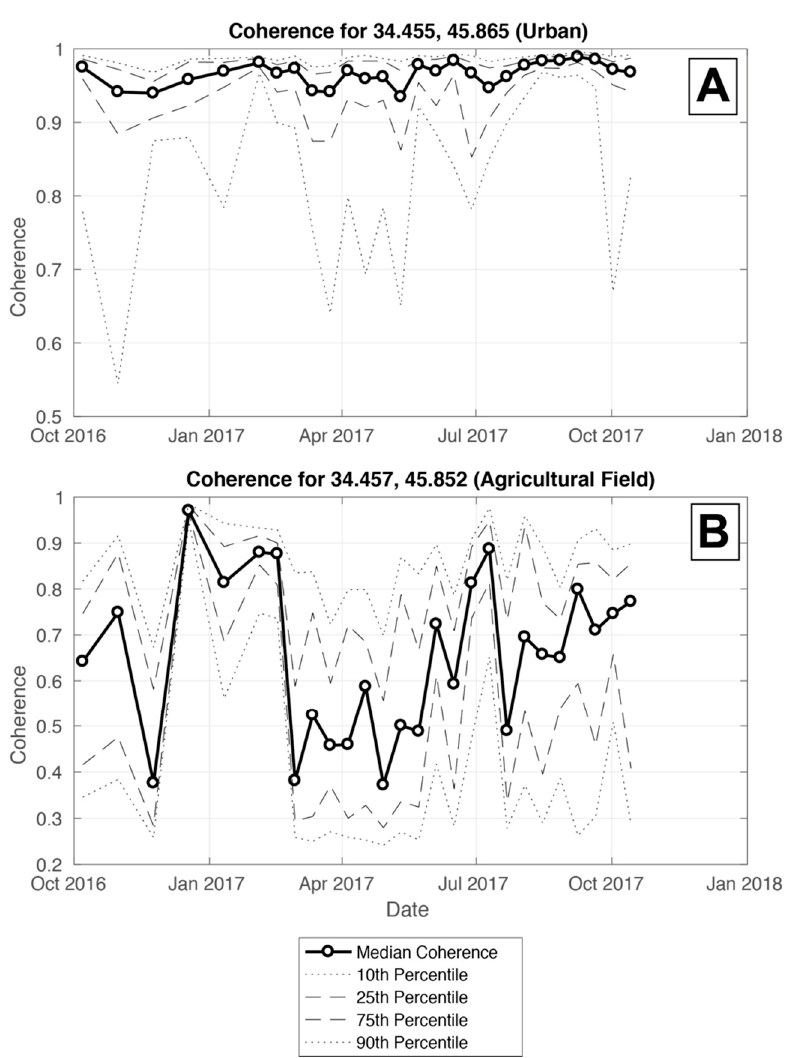
Figure 3. Time series of coherence preceding the 12 November 2017 earthquake for ( A ) An urban structure (yellow triangle in Figure 2A); and ( B ) Agricultural field (white inverted triangle in Figure 2A) in the region of Sarpol-e, Iran. Coherence was calculated for each adjacent date (e.g., date-1 & date-2; date-2 & date-3) and averaged over a 10 × 10 pixel window. This highlights the differences between coherence over time in regions classified as “most reliable” ( A ) and “least reliable” ( B ). Coherence was calculated for SAR images from 7 November and 19 November